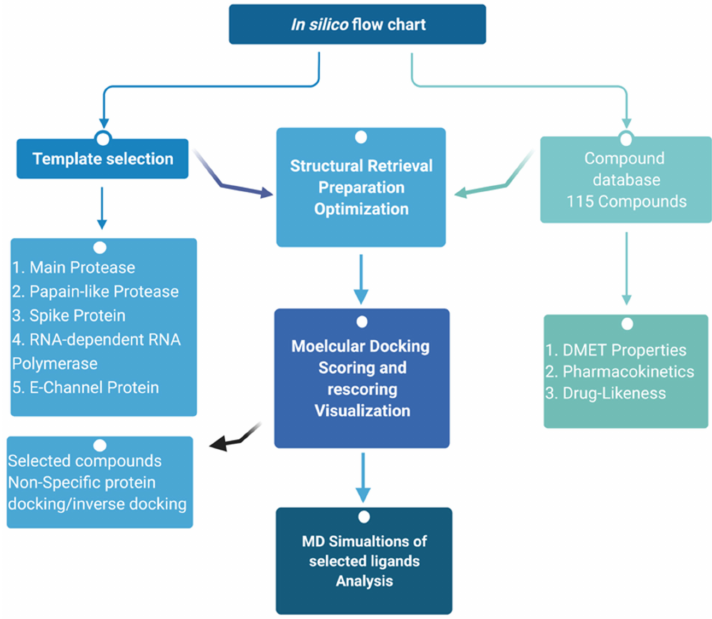
Figure 15. Flow diagram of Methodology.